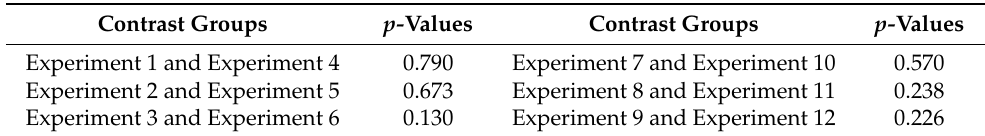
Table 8. Mann – Whitney U test of the effects of leadership style on supply. Contrast Groups